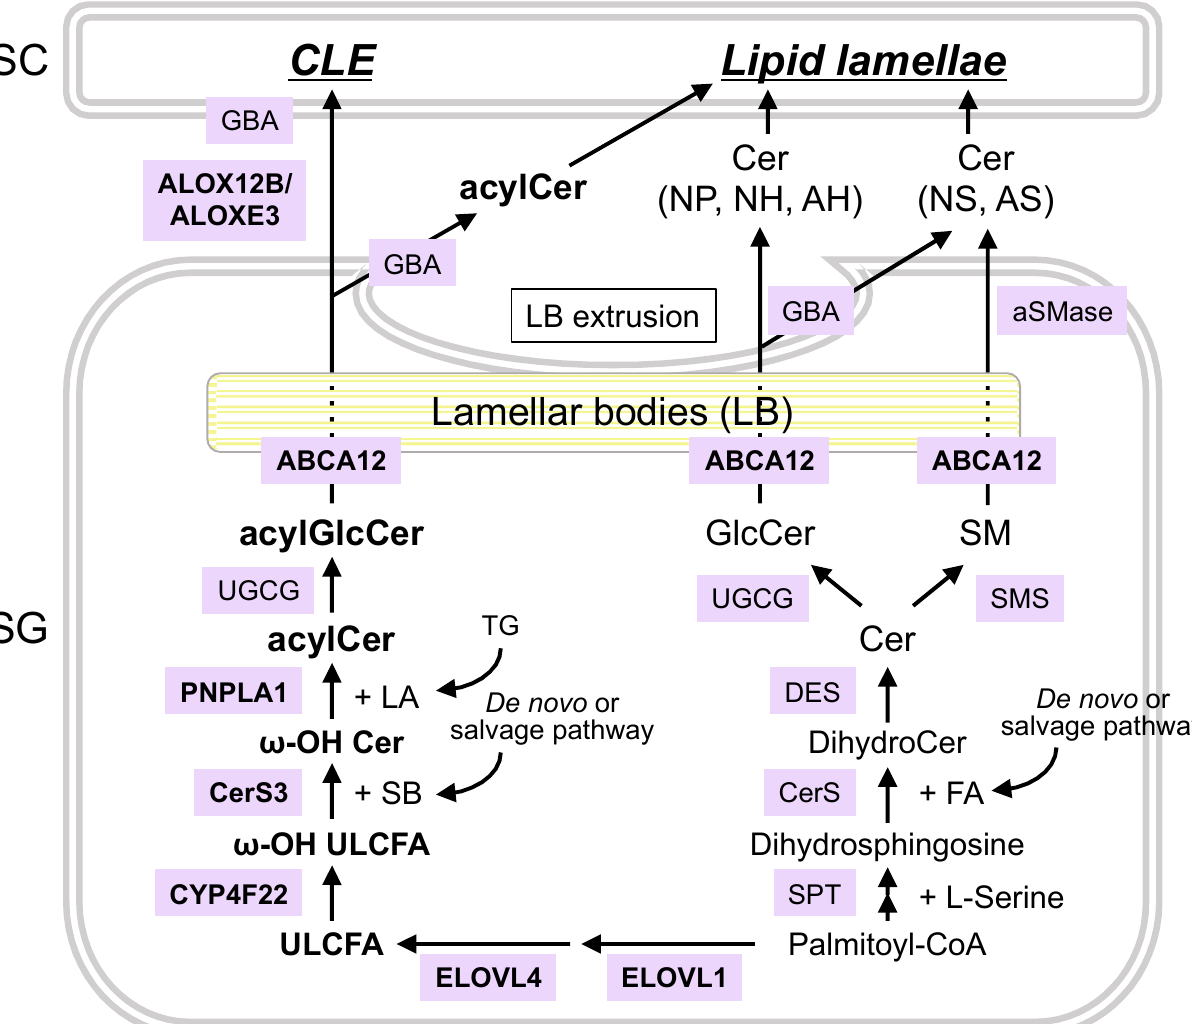
Figure 3. Synthetic pathways of epidermal ceramides (Cer). GlcCer, glucosylceramide; SM, sphingomyelin; ULCFA, ultra-long-chain fatty acid; acylCer, acylceramide; SB, sphingoid base; LA, linoleic acid; TG, triglyceride; SPT, serine palmitoyl-CoA transferase; CerS, ceramide synthase; DES, desaturase; UGCG, UDP-glucose ceramide glucosyltransferase; SMS, sphingomyelin synthase; ABCA12, ATP-binding cassette transporter 12; GBA, β -glucocerebrosidase; aSMase, acid sphingo- myelinase; ELOVL, elongase of very long-chain fatty acid; CYP, cytochrome P450; PNPLA1, patatin- like phospholipase domain-containing 1; ALOX12B, 12 R -lipoxygenase; ALOXE3, epidermis-type lipoxygenase-3.